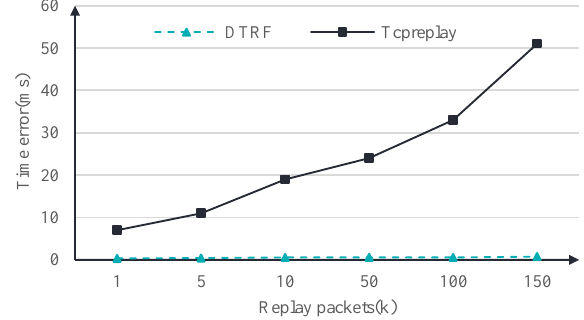
Figure 8. Timestamp error comparison.